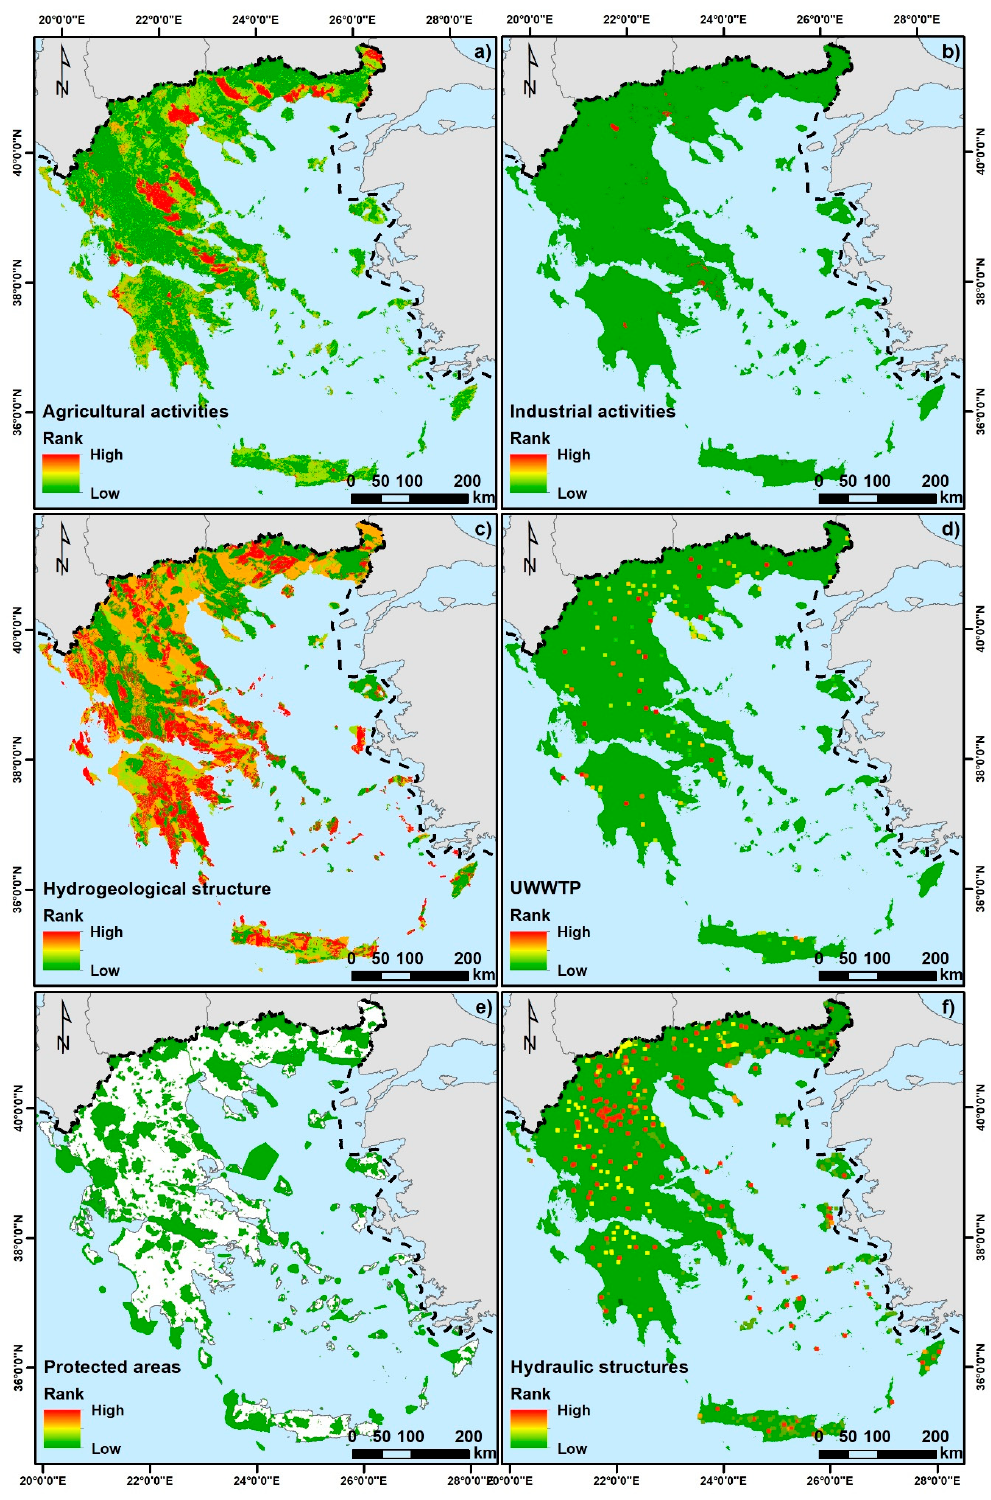
Figure 3. Conditioning factors increasing the need for water quality monitoring. ( a ) Agricultural activities, ( b ) industrial activities, ( c ) Hydrogeological structure, ( d ) UWWTP, ( e ) protected areas, and ( f ) hydraulic structures in rivers.